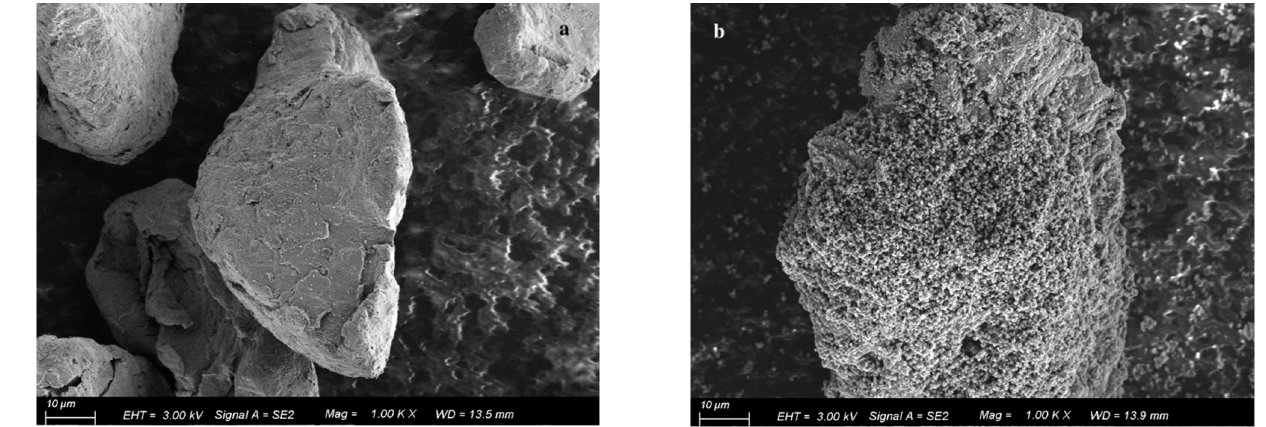
Figure 3. SEM images of raw magnesium powder and etched magnesium powder: ( a ) the SEM image of raw magnesium powder; ( b ) the SEM image of magnesium powder after acid etching.